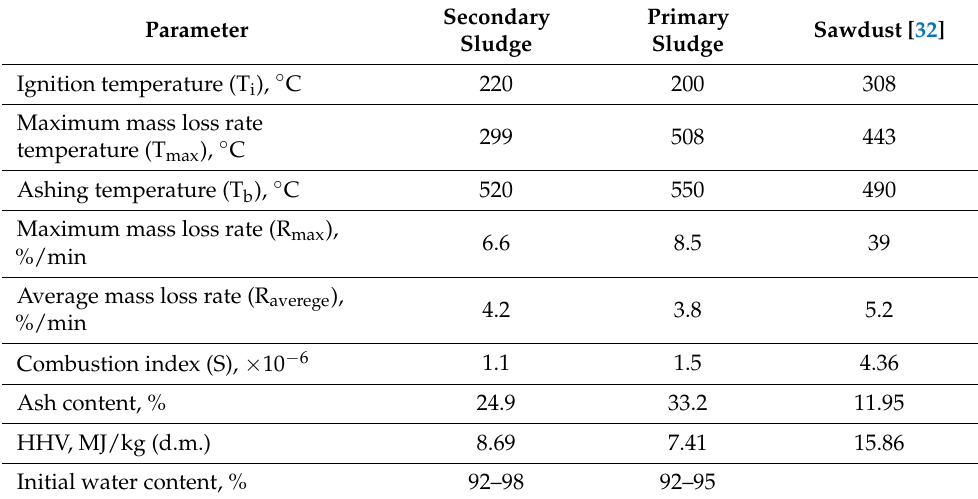
Table 3. Main thermal characteristics of primary and secondary